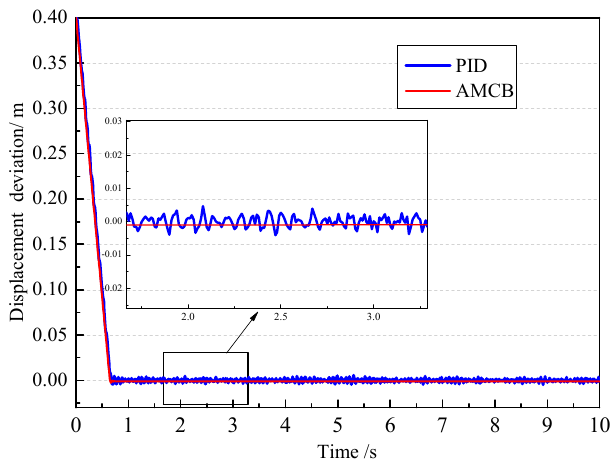
Figure 10. Step response displacement error curves.